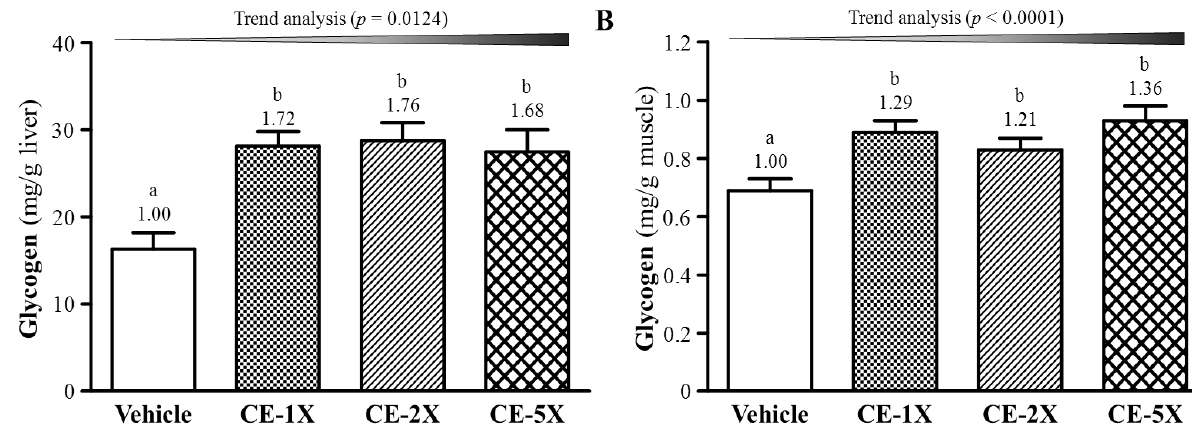
Figure 4. Effect of 4-week CE supplementation on hepatic ( A ) and muscle ( B ) glycogen level. Data are mean ± SEM for n = 10 mice per group. Bars with different letters (a, b) are significantly different at p <